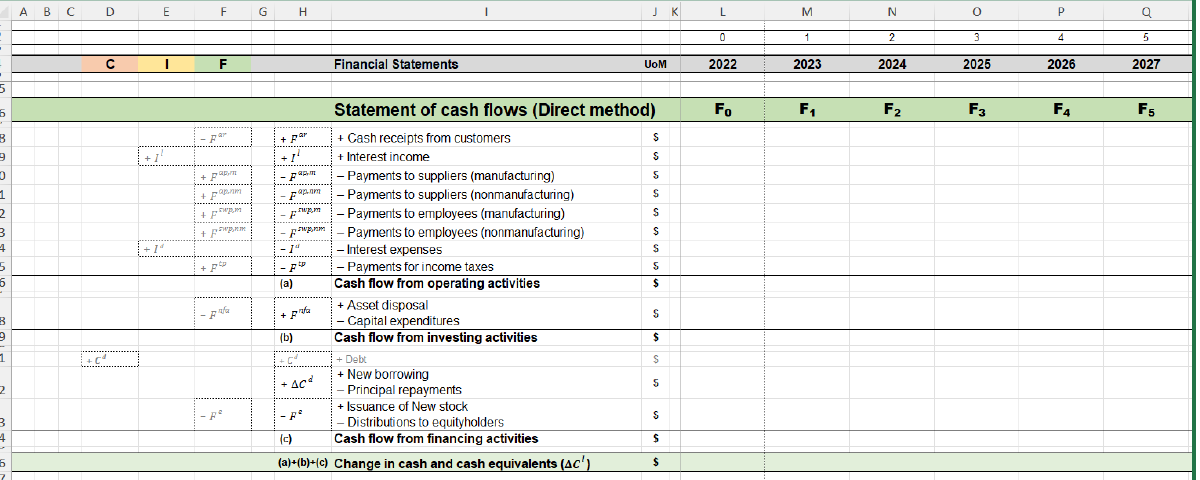
Figure 50. Structure of the cash flow statements in the spreadsheet (“ConventionalFinStat” sheet). Each row contains a label in column D, E, or F: they are references of the values in the split-screen strip and report the capital amounts, incomes, and cash flows.